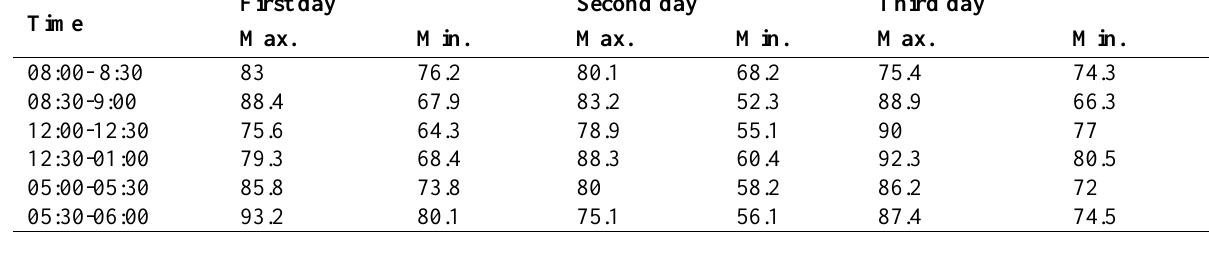
The reason behind the high levels of noise pollutions refers to that this site contains many shops of maintenance workshops and operation and maintenance of cars also repairing parts of those vehicles flashed and made accidents. . Third day Second day First day